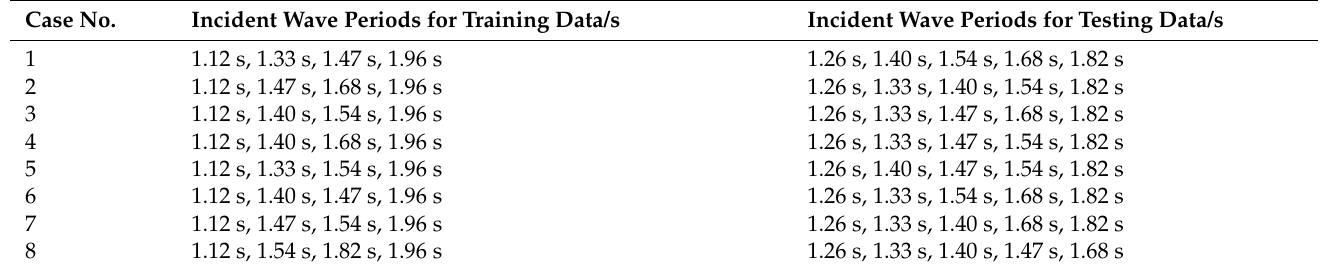
Table 6. Arrangement of training and testing data (4 training data points).